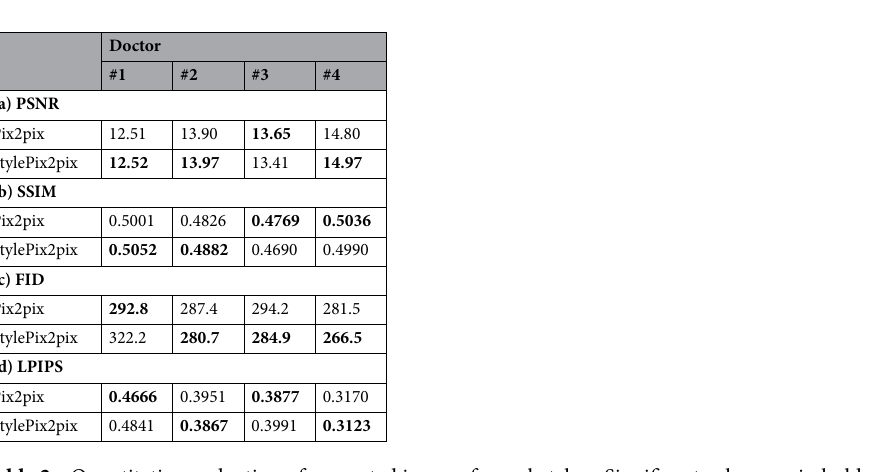
Table 2. Quantitative evaluation of generated images from sketches. Significant values are in bold.